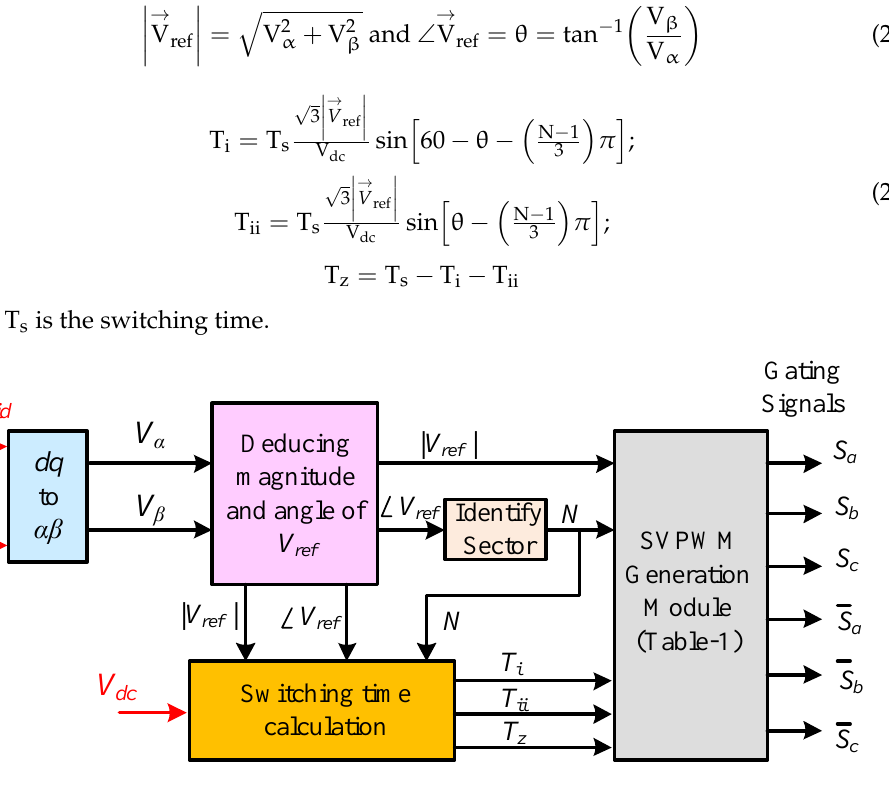
Figure 3. Block diagram for the implementation of the Conventional space vector pulse width modulation Technique.